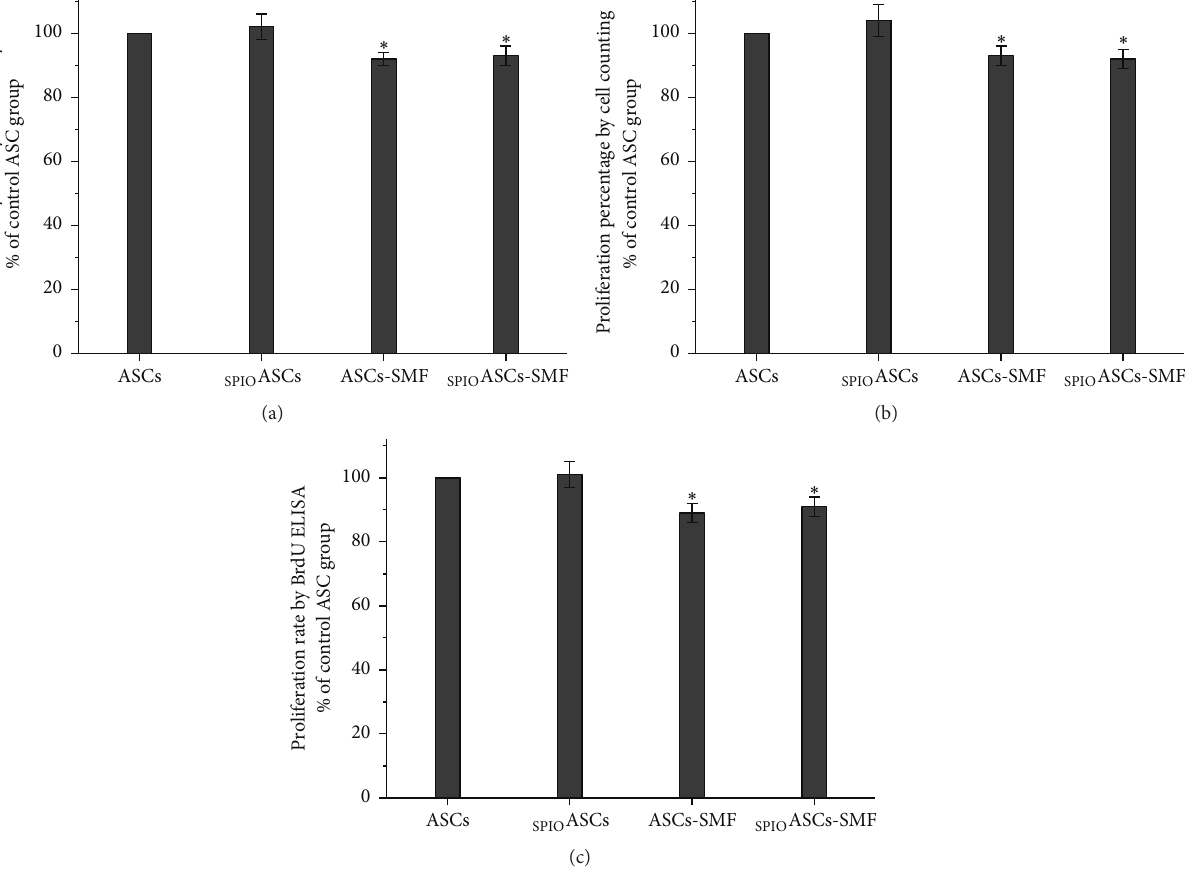
Figure 3: Effect of seven-day exposure to 0.5 T SMF on cell viability and proliferation in ASCs and SPIO ASCs. (a)–(c) Cell proliferation was assessed by cell counting (b) and BrdU assay (c). The cell viability (a) and proliferation rate ((b)-(c)) were significantly lower in the ASCs-SMF and SPIO ASCs-SMF than in ASCs and SPIO ASCs. ∗ 𝑃 < 0.05 versus ASCs or SPIO